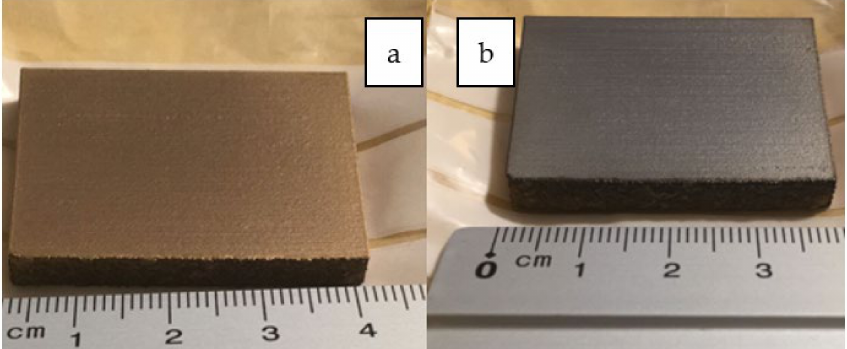
Figure 6. Zones of AlTiSiN samples of set 3: ( a ) coated surface and ( b ) uncoated